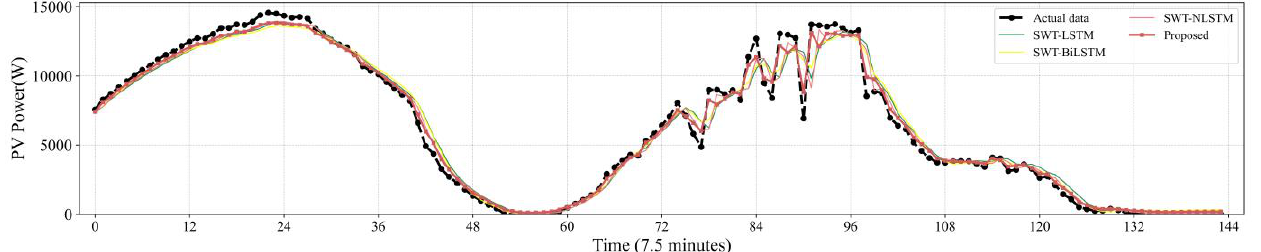
Figure 10. Contrasting the performance evaluation of the proposed model and LSTM networks combining SWT.